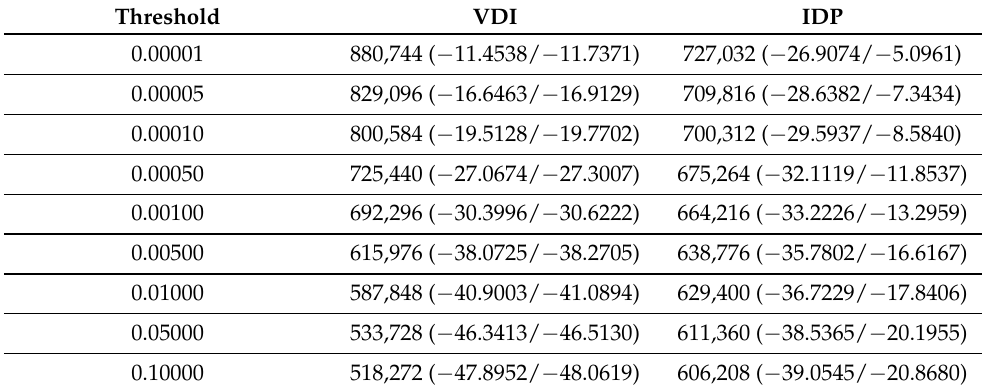
Table 10. munin —Global approximation memory size